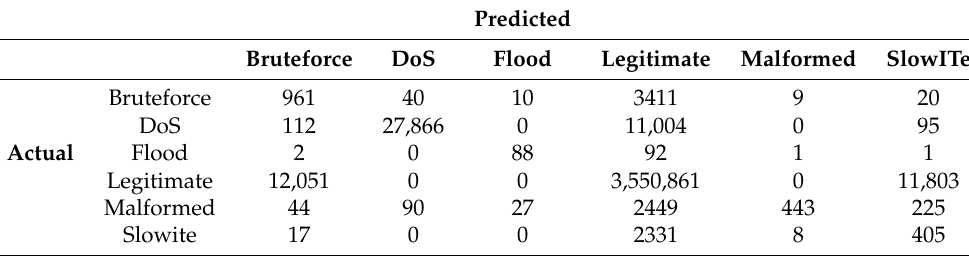
Table 8. Confusion matrix naïve bayes.